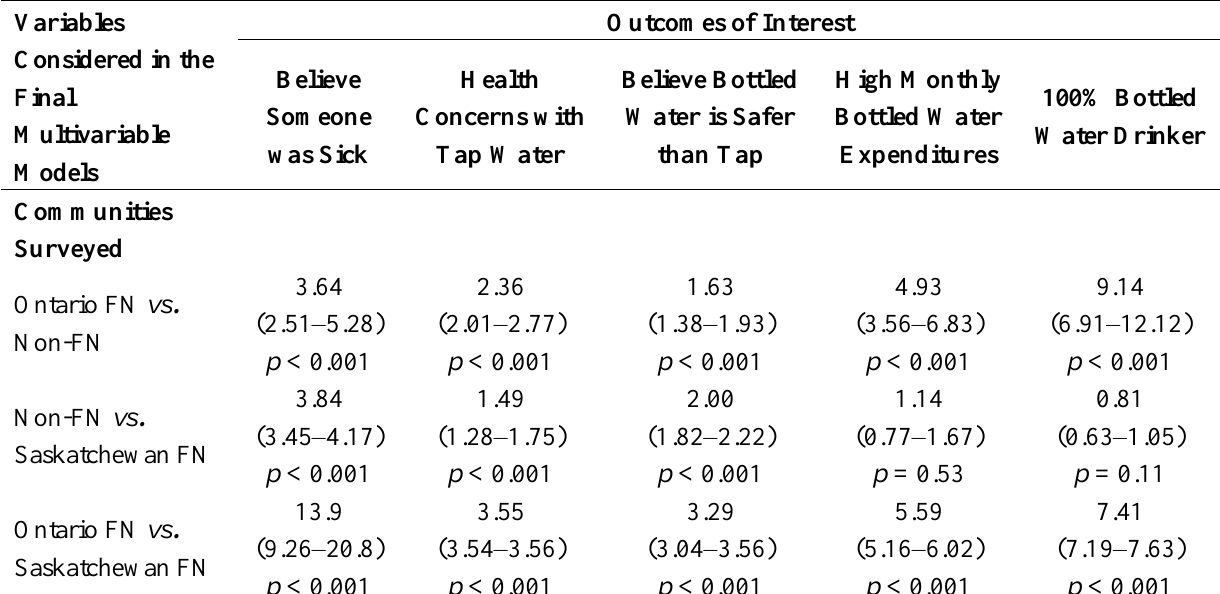
Table 2. Summary of the final multivariable models examining the association between community, age, gender and reported health risk beliefs and choices for bottle water consumption in three groups of Canadian communities reported as odds ratios (OR) adjusted for all other variables in the final models and 95% confidence intervals (95%